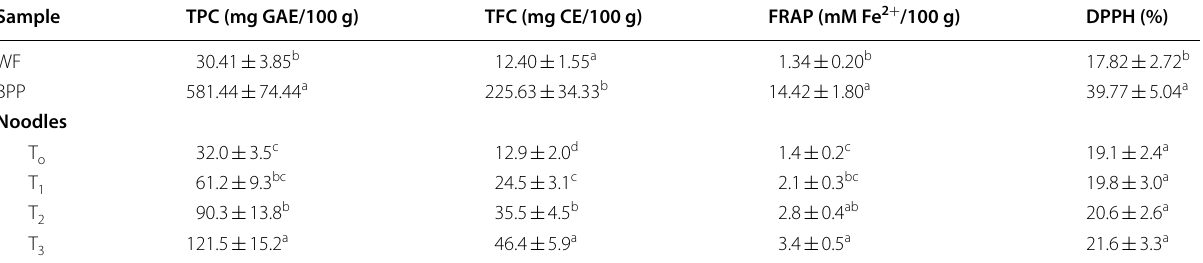
Values are means of triplicates HSD-Tukey